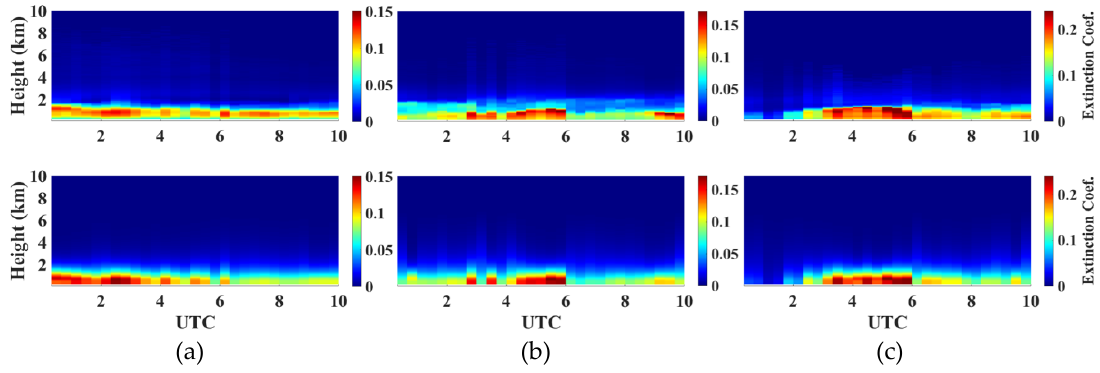
Figure 10. The comparisons between the measurements of the MPLNET NCU_Taiwan site (upper panels) and the fitted extinction profiles (bottom panels) every 20 minutes during the daytime on ( a ) 2006/12/23, ( b ) 2008/10/19, and ( c ) 2013/09/08.